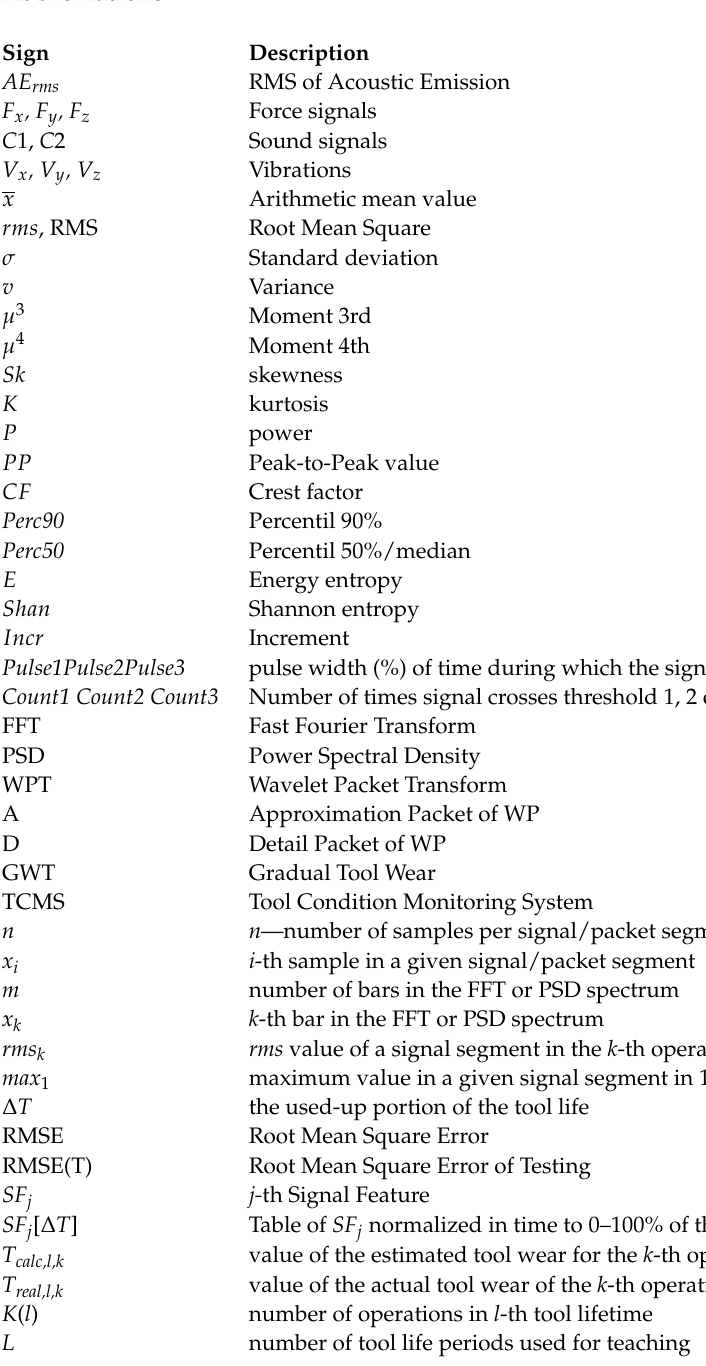
Table of SF j normalized in time to 0–100% of the tool life T calc,l,k value of the estimated tool wear for the k -th operation of l -th tool life; value of the actual tool wear of the k -th operation l -th lifetime of the tool K ( l ) number of operations in l -th tool lifetime L number of tool life periods used for